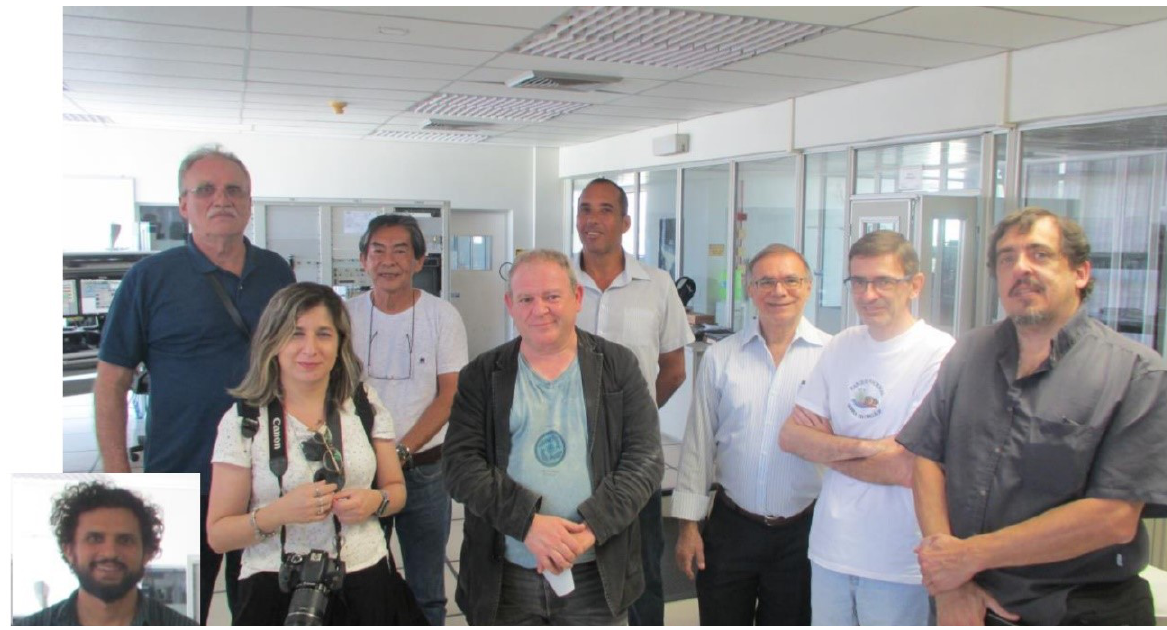
Figure 6. Technical visit to the Tanguá antenna in “Estacao Terrena da Embratel” on September 19,